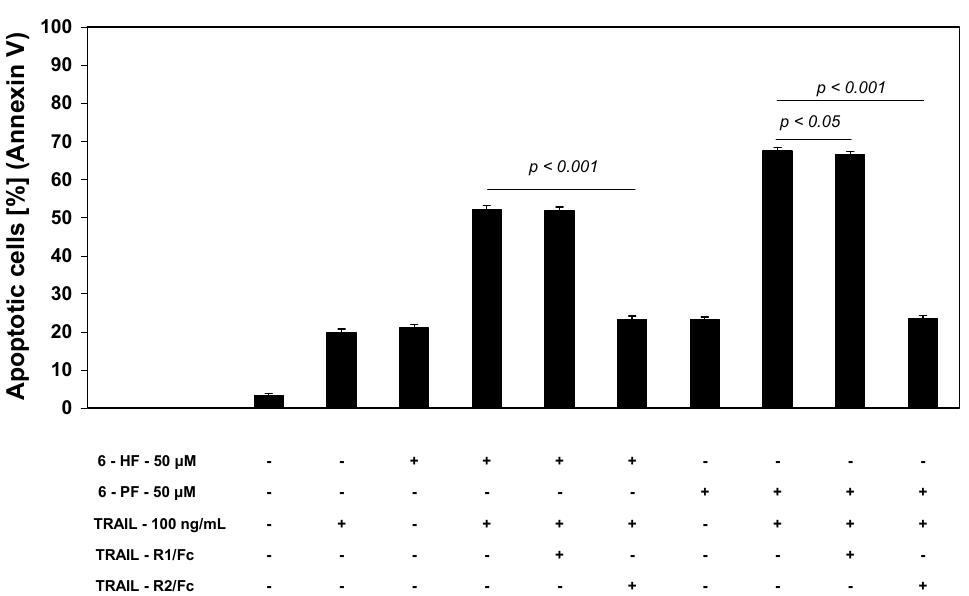
Figure 5. TRAIL-R2/Fc chimera block apoptosis induced by combination of TRAIL and synthetic flavanones in HeLa cancer cells. Cells were incubated for 48 h with 100 ng/mL TRAIL and/or 50 μ M 6-HF or 6-PF with or without 1 μ g/mL TRAIL-R1/Fc or TRAIL-R2/Fc chimera proteins. Apoptotic cell death was detected by annexin V-FITC staining using flow cytometry. The values represent mean±SD of three independent experiments performed in